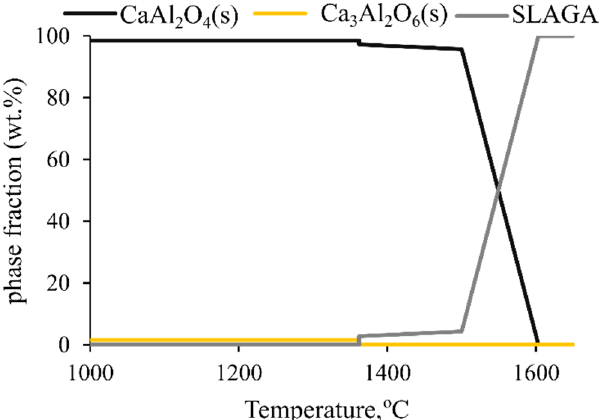
Figure 14. Predicted solidified slag phases for smelting in Al 2 O 3 crucible as estimated with FactSage equilibrium calculations.